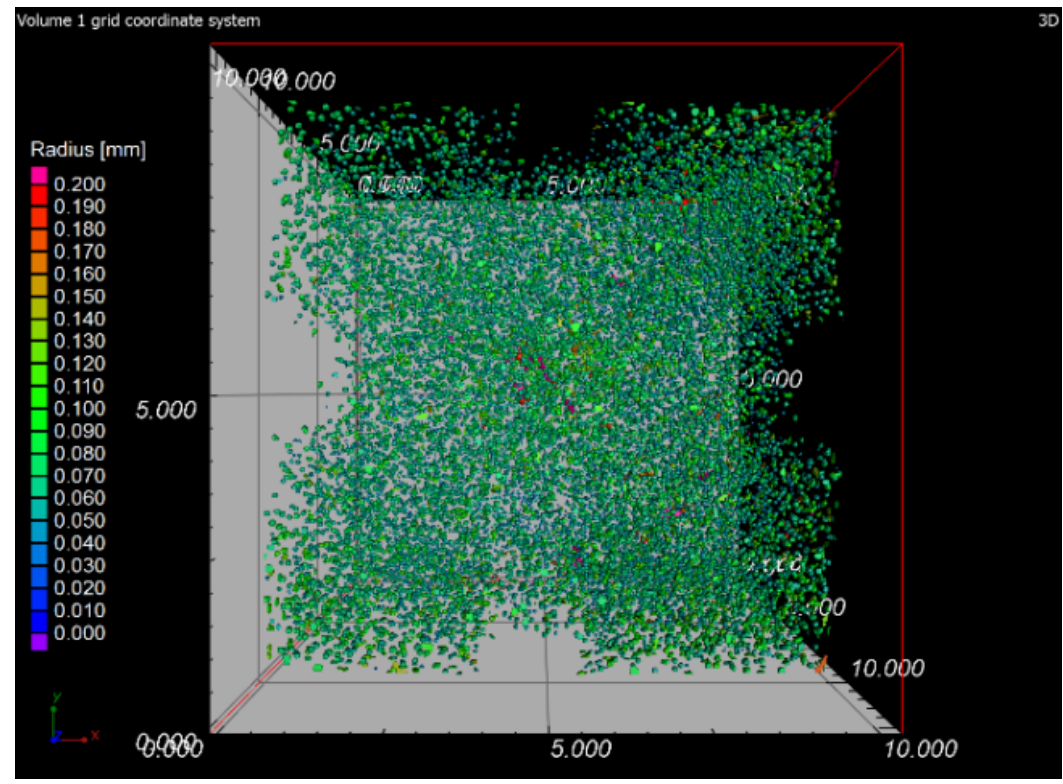
Figure 24. 3D illustration of pore distribution in sample 5 after SLM.